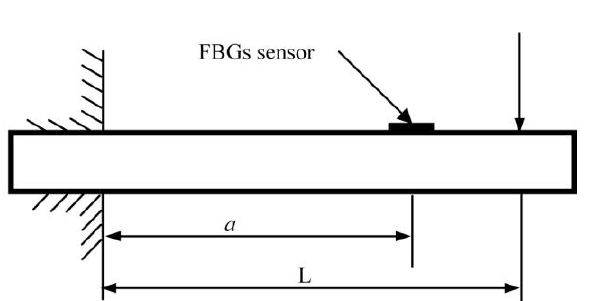
Figure 4. Test principle